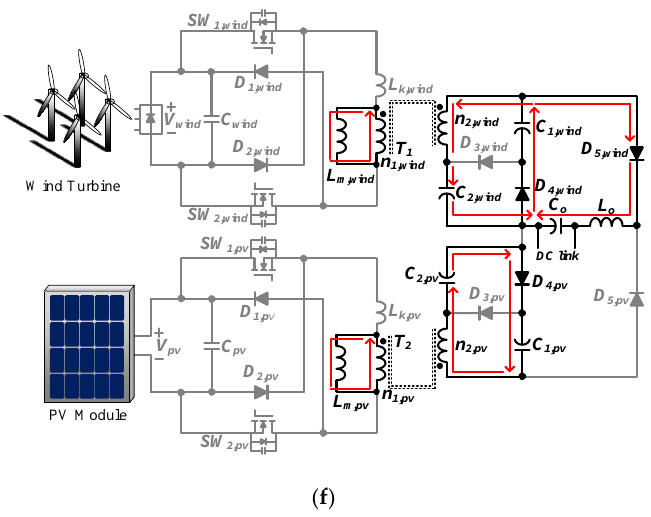
Figure 2. Equivalent circuits of the DIPWC: ( a ) Stage 1, ( b ) Stage 2, ( c ) Stage 3, ( d ) Stage 4, ( e ) Stage 5, and ( f ) Stage 6.